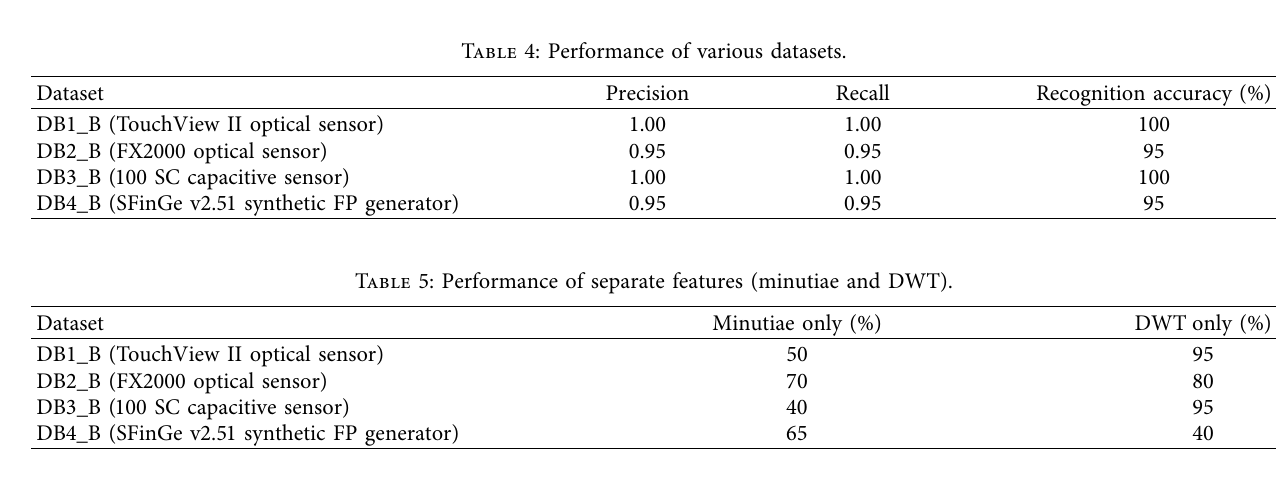
Table 6: A comparative analysis of experimental results using the FVC 2002 DB1_B dataset.